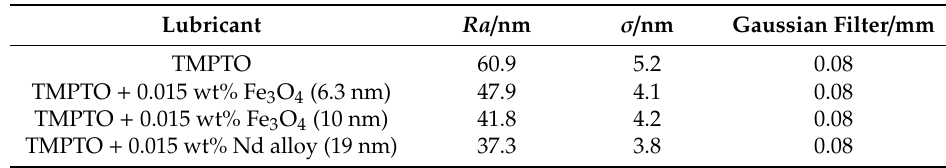
Table 5. Roughness parameters, Ra , and their uncertainties σ of worn surfaces lubricated with the three studied nanodispersions and neat